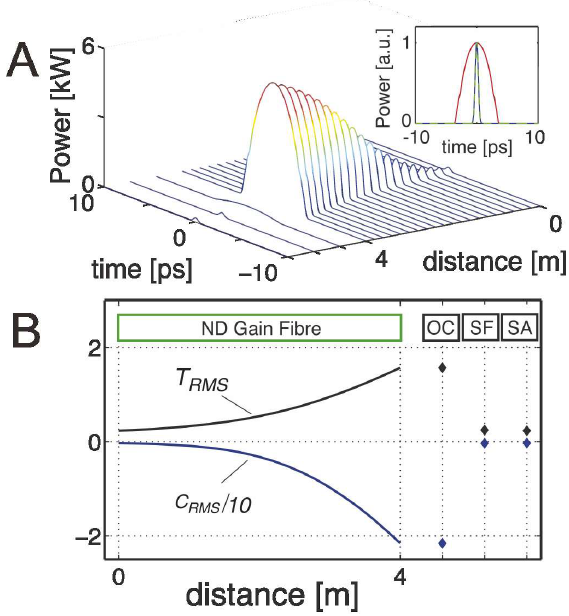
Figure 6: The (A) temporal profile, (B) power and chirp evolutions during one round trip in a self-similar fiber laser cavity. (Adapted from